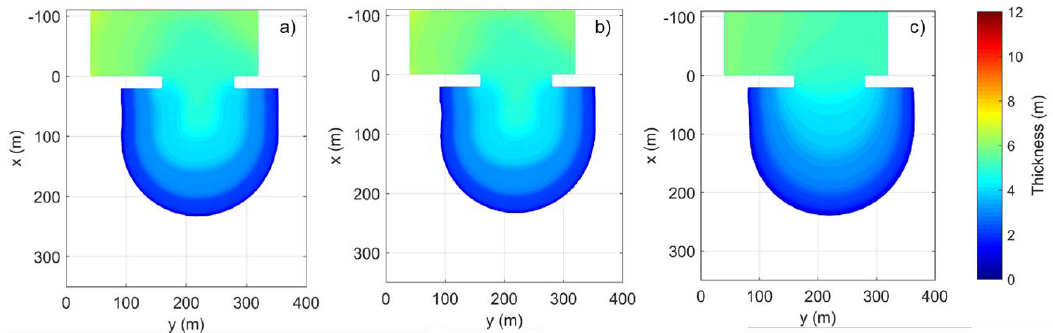
Figure 6. The free-surface profiles of tailings ( a ) by Bingham model (BM) with 𝛾̇ 𝑦 = 0.0 s −1 , ( b ) by conventional bi-viscosity model (CBM) with 𝛾̇ 𝑦 = 1 × 10 −4 s −1 , ( c ) by conventional bi-viscosity model (CBM) with 𝛾̇ 𝑦 = 2 × 10 −1 s −1 .